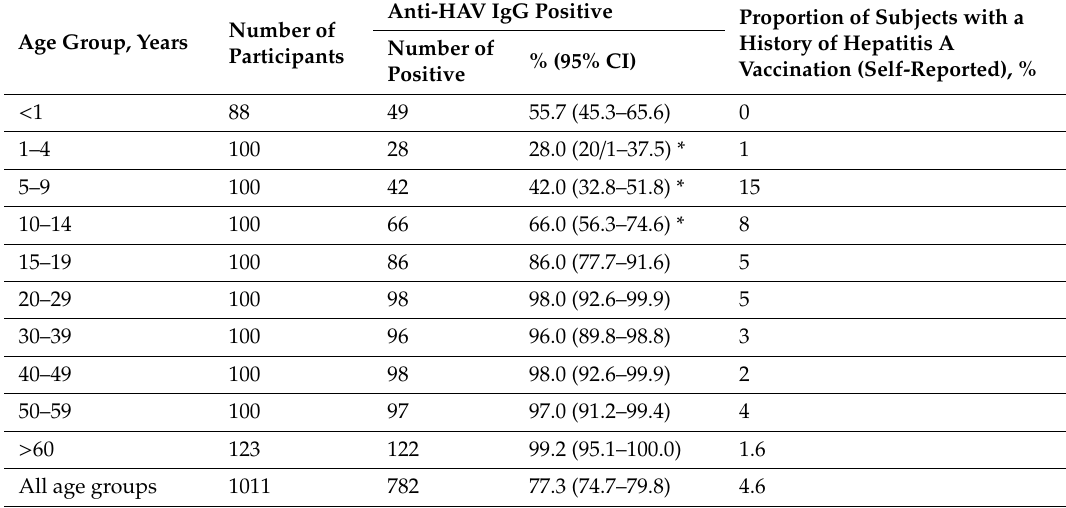
Table 2. Prevalence of anti-HAV IgG in conditionally healthy individuals in Tuva in the pre-vaccination period (in